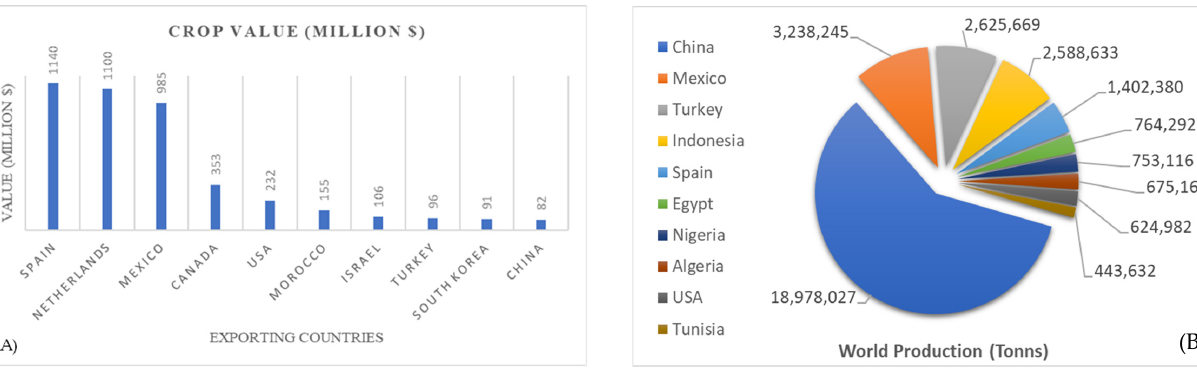
Figure 3. The 10 largest exporters of sweet and chilli pepper: ( A ) crop value in million USD, and ( B ) production (FAO- STAT,